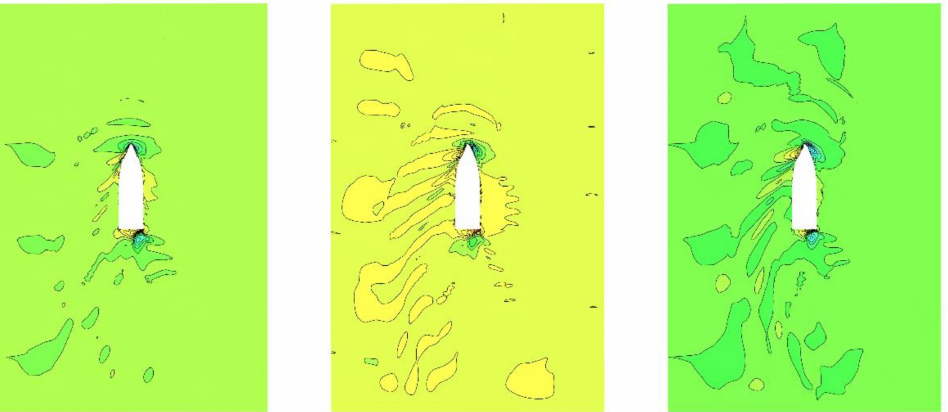
Figure 6. Coupled ripple of oblique motion and circumferential motion ( left : dimensionless steering angular speed is 0.4, drift angle is 0 degrees; middle : dimensionless steering angular speed is 0.4, drift angle is − 10 degrees; right : dimensionless steering angular speed is 0.8, drift angle is − 10 degrees).